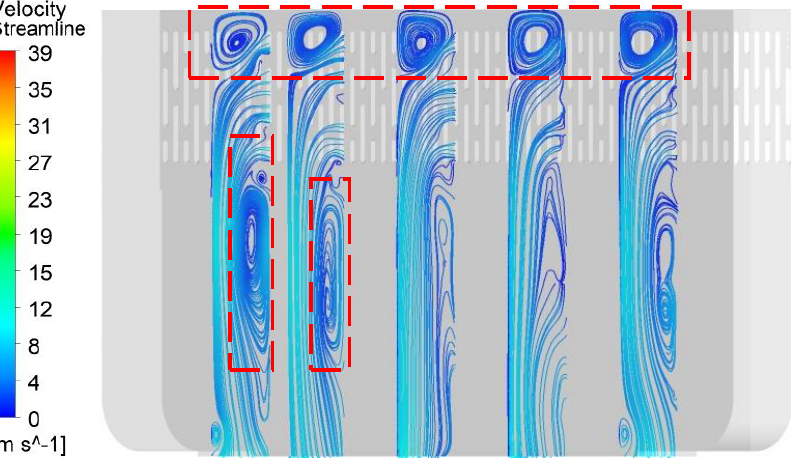
Figure 7. Cross-sectional flow diagram in the X-direction within the prototype head duct of the integrated stove.